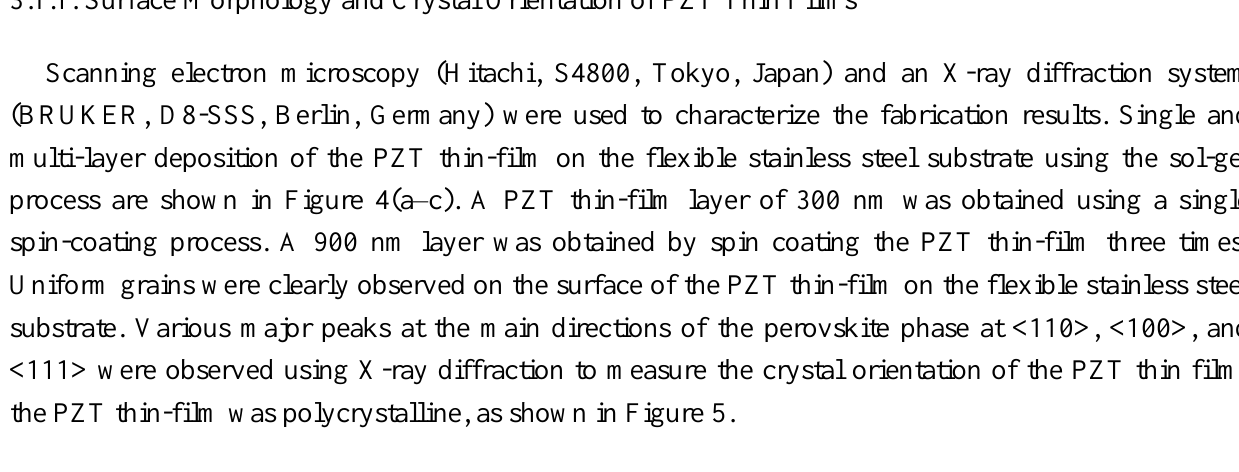
Figure 4. PZT thin films deposited from single or multilayer spin coating ( a ) single layer ( b ) double layer ( c ) triple